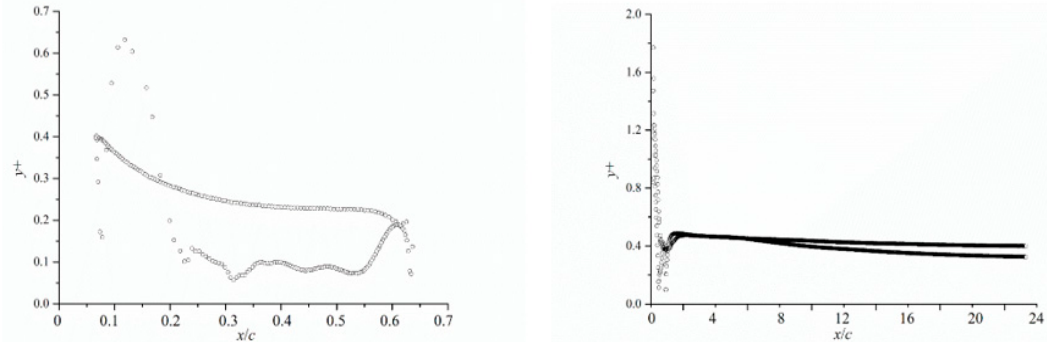
Figure 2. Wall y + distribution of airfoil blade ( left ) and flat plate ( right ).